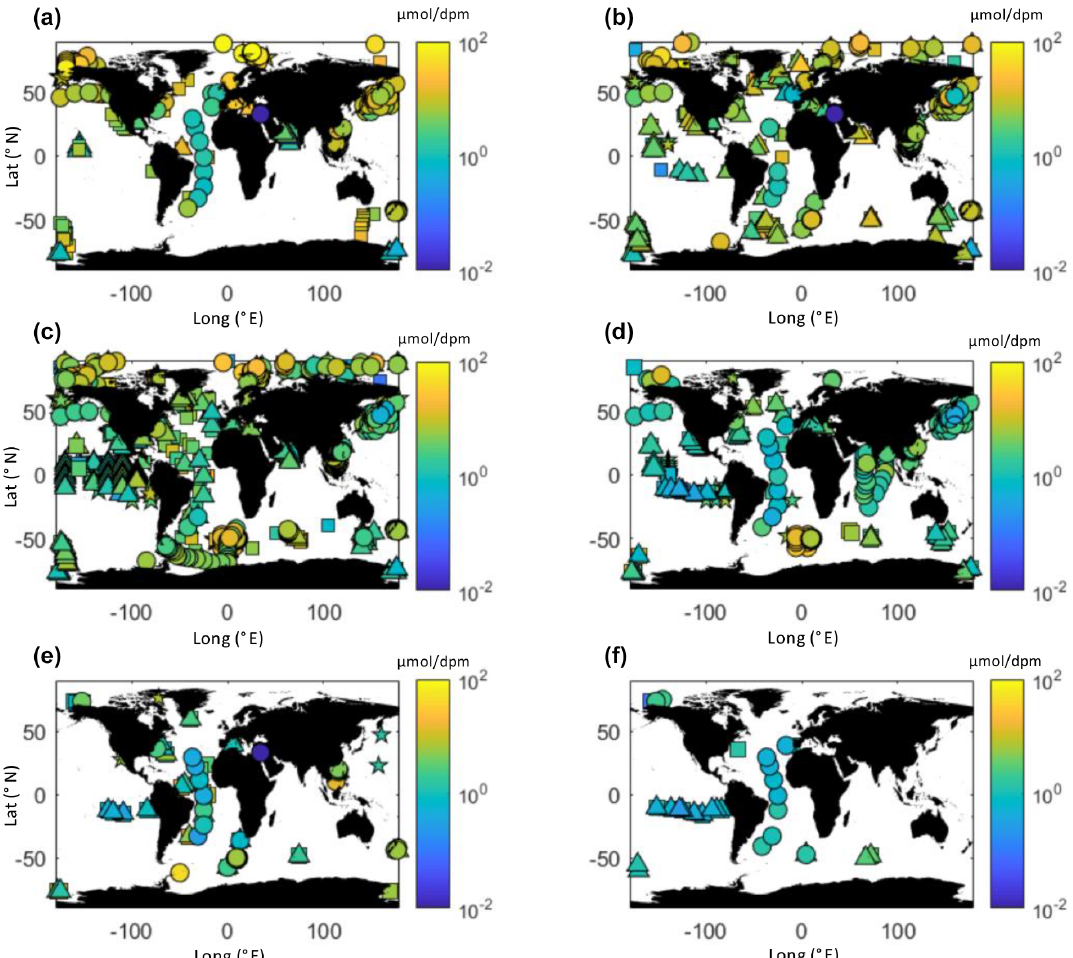
Figure 2. Global distribution of the POC / Th ratios ( < 100µmoldpm − 1 ) (a) in surface, (b) at 50m, (c) at 100m, (d) at 200m, (e) at 500m, and (f) at 1000m. Circles represent BU, squares represent LP, triangles represent SP, and stars represent ST (see main text for details, Sect. 3.1 Data classification.). Data correspond to samples collected at depths at ± 5m the nominal depth for all cases, except for panel (f) ( ±